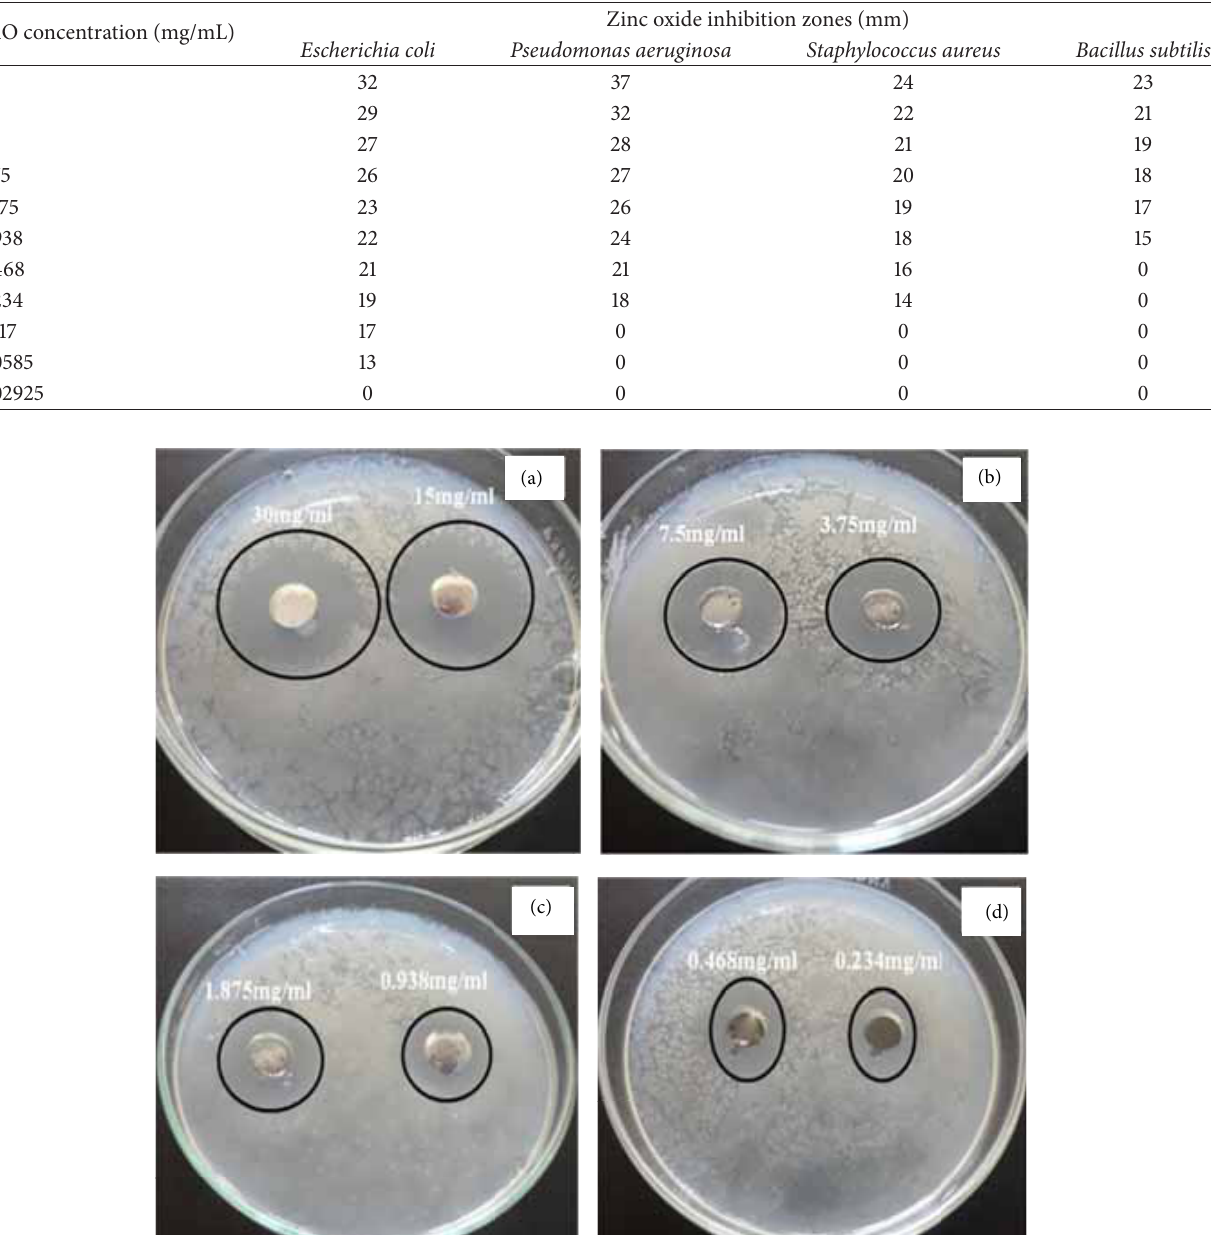
Table 2: The antimicrobial activity as measurable inhibition zones against different bacterial strains using various concentrations of ZnO nanotubes suspensions .